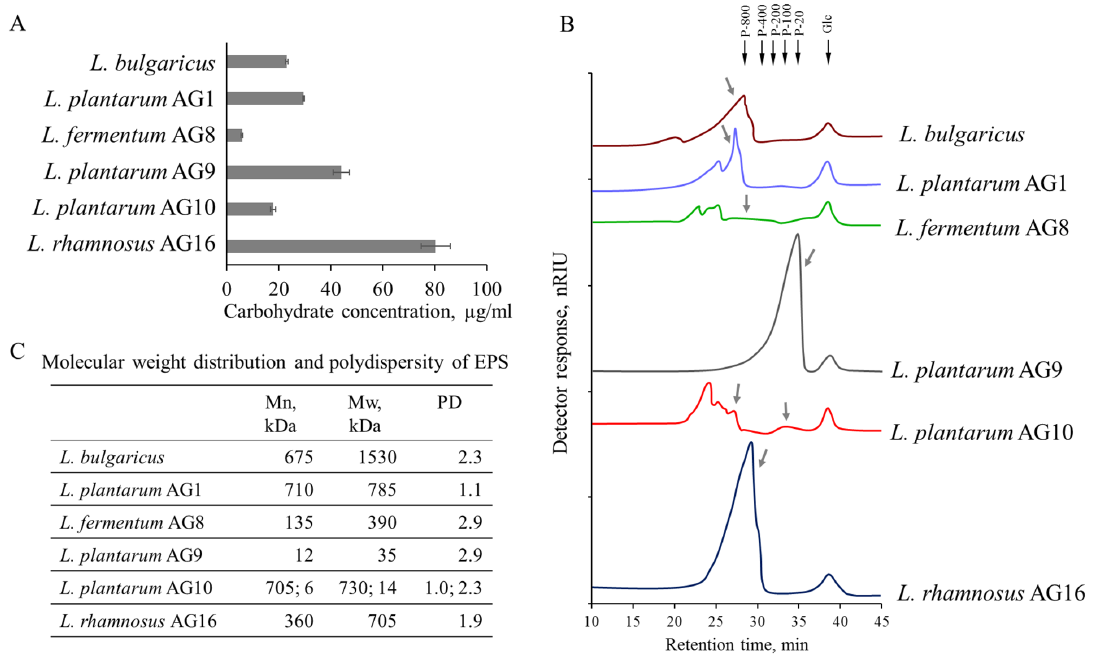
Figure 3. Yield ( A ) and molecular weight distribution ( B , C ) of EPS produced by various Lactobacillus species of silage and isolated from fermented skim milk. The number average (Mn) and weight average (Mw) molecular weights ( C ) are given for peaks indicated by gray arrows ( B ). Some of the peaks in the chromatograms ( B ) are outside the calibration curve (molecular weight parameters are not given for them). Pullulans with a low polydispersity index and glucose were used as molecular weight markers at gel filtration.